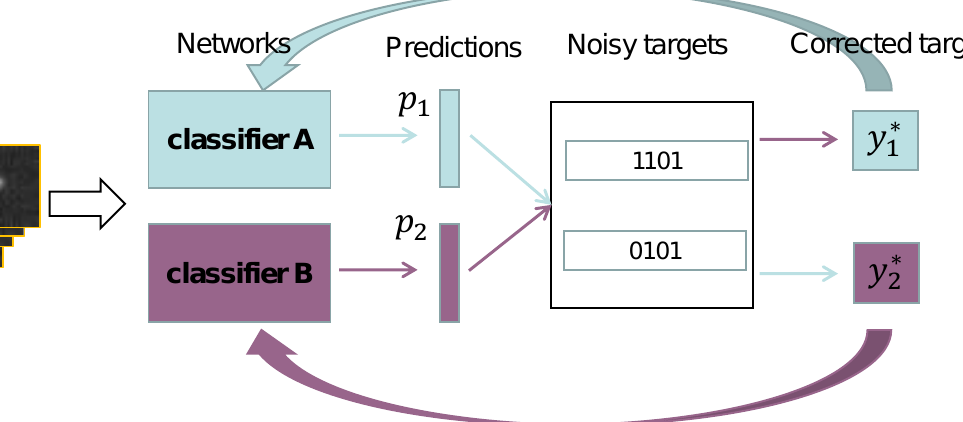
Figure 3. The schematic of Co-correcting. In Co-correcting, two networks make predictions on same mini-batch data, and the noisy labels are corrected by peer networks’ predictions. The new corrected labels then guide the training of the networks. We can see that each network is under supervision of its peer